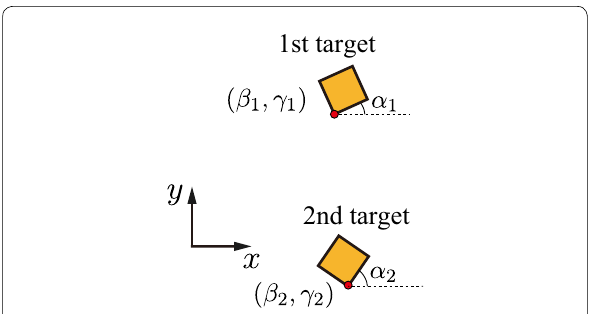
Fig. 6 Parameterization of the calibration targets ( xy -plane). The parameters β i and γ i represent the location of the i -th target, and α i represents the rotation of the i -th